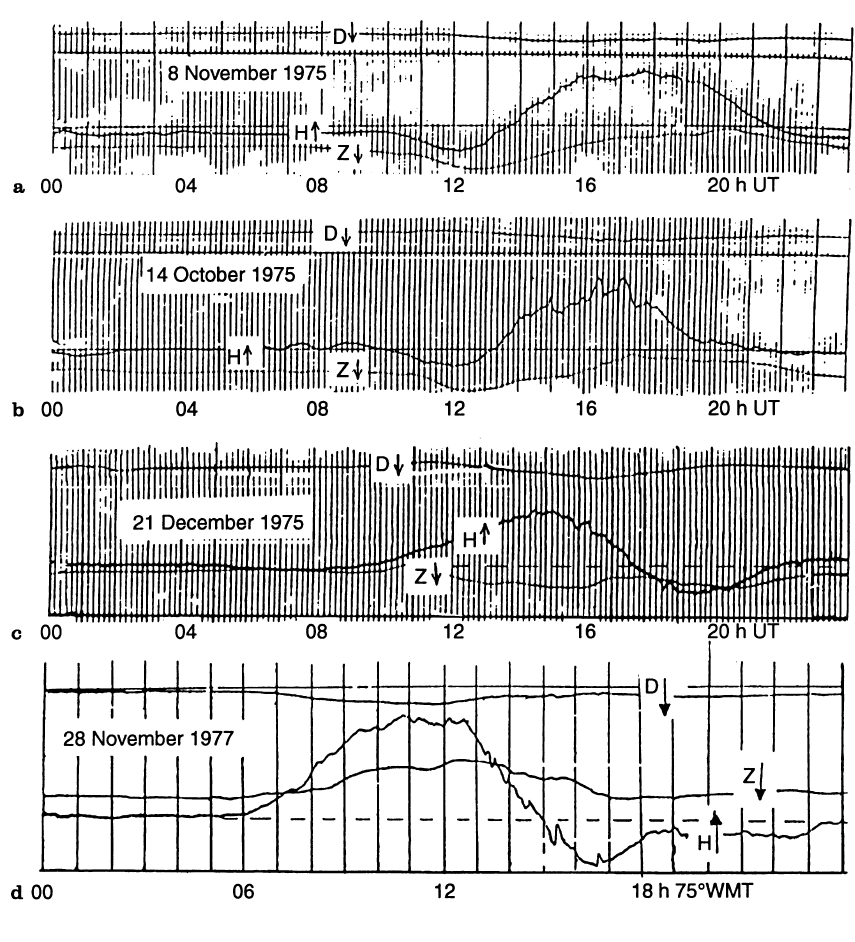
Fig. 5. Reproduction of the magneto- grams at Huancayo on some days with a counter